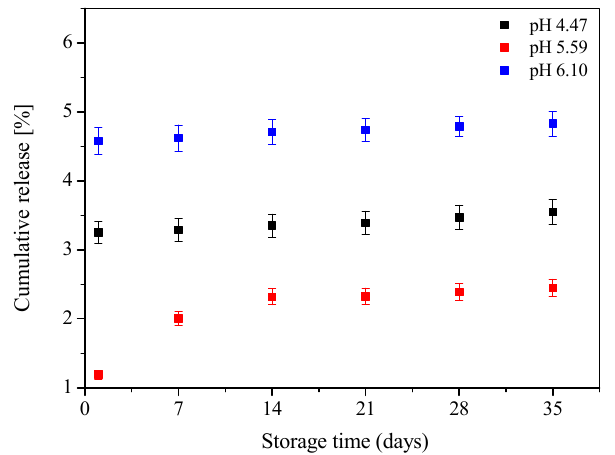
Figure 3. Drug release profiles of chloride-5-methyl-12(H)-chino[3,4-b]-1,4-benzothiazine (5-MBT) loaded in the liposomes obtained in different pH.